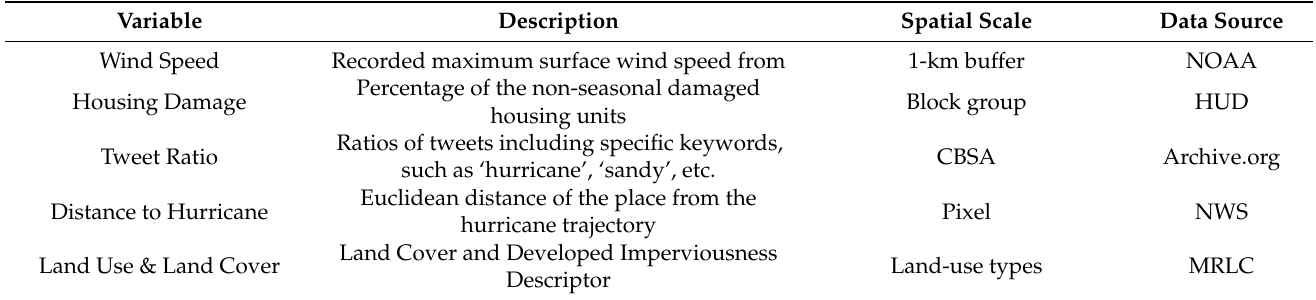
Table 1. Description of auxiliary